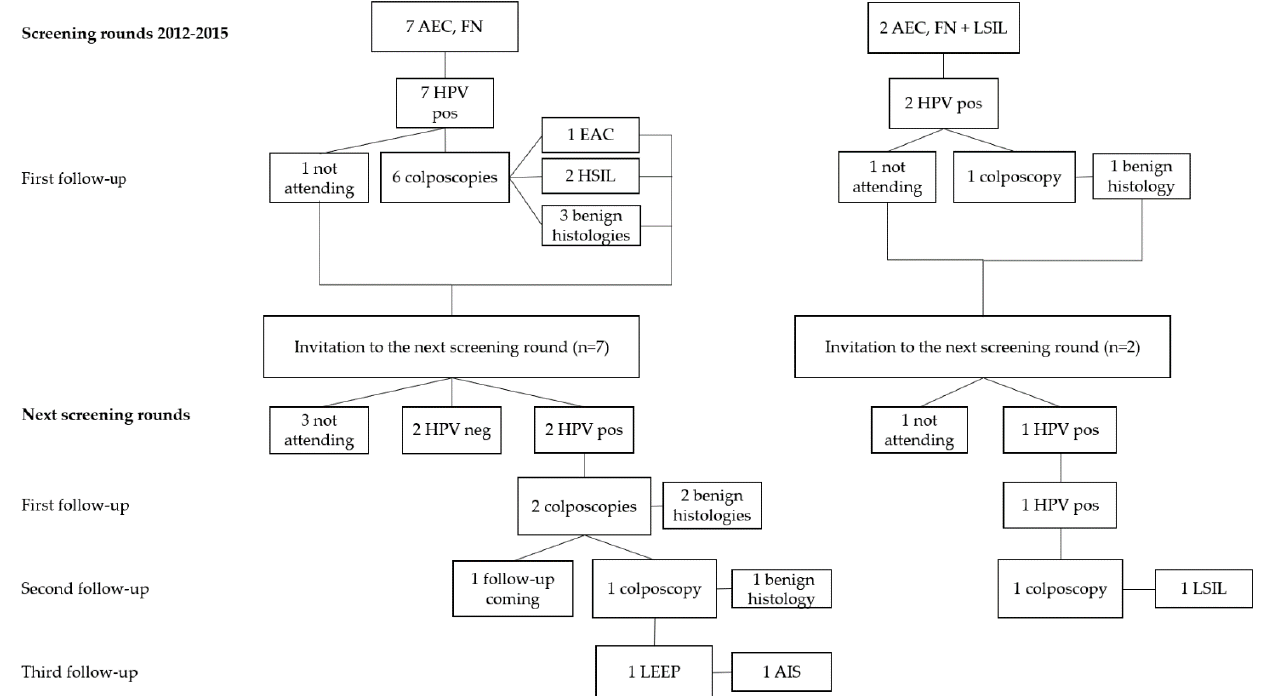
Figure 3. The outcome of two consecutive HPV primary cervical cancer screening rounds of patients with atypical endocervical, favoring neoplastic with or without a squamous cell atypia in cytology. Abbreviations representing cytological diagnoses: AEC, FN, Atypical Endocervical Cells, Favor Neoplastic; AEC, FN + LSIL, Low-Grade Squamous Intraepithelial Lesion. Abbreviations representing histological diagnoses: EAC, Endocervical Adenocarcinoma; LSIL, Low-Grade Squamous Intraepithelial Lesion; HSIL, High-Grade Squamous Intraepithelial Lesion. Other abbreviations: HPV, human papillomavirus; pos, positive; neg, negative; LEEP, loop electrosurgical excision procedure.